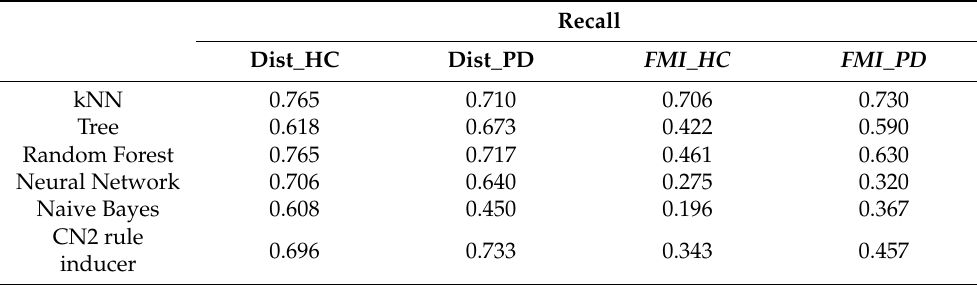
Table A2. Recall. Dist_HC and Dist_PD refer to the dataset of normalized distances with the preprocessing step of PCA whereas FMI_HC and FMI_PD refer to the FMI dataset.